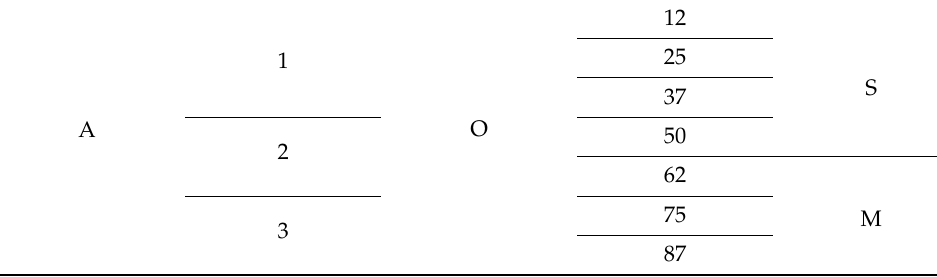
Figure 5. Rectangular regions representing the likely damage-enclosing sections. Table 2. Nomenclature to uniquely identify each